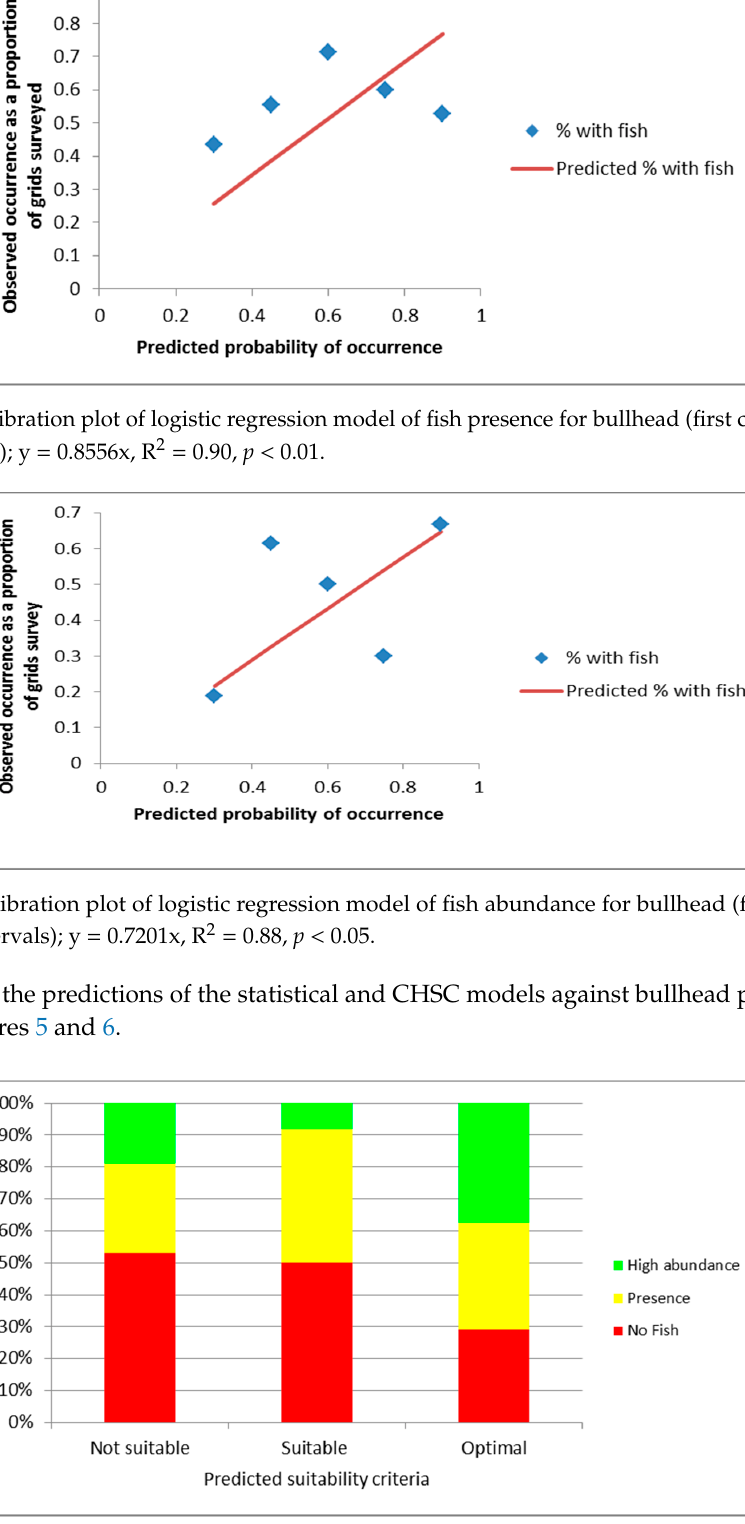
Figure 5. Comparison between results of the statistical model and results of bullhead sampling in the Stura di Demonte. The x-axis shows predicted suitability criteria in three different classes: not suitable, suitable, and optimal. Fish presence class is shown by colors.